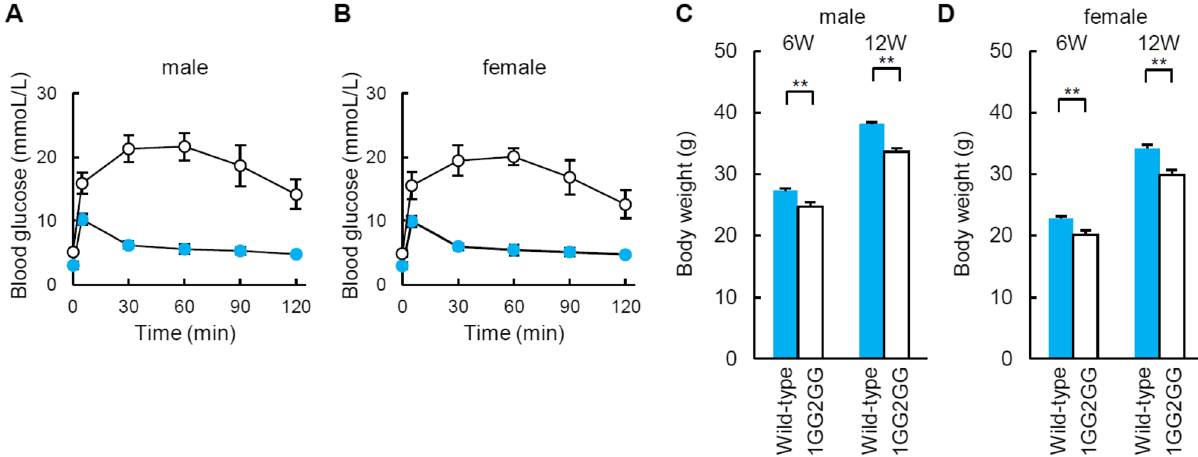
Figure 6. Glucose tolerance test and body weights of 1GG2GG mice. ( A , B ) Intraperitoneal glucose tolerance testing of wild-type (blue: n = 6) and 1GG2GG mice (white: n = 6) at 12 weeks of age [( A ): male, ( B ): female]. ( C , D ) Body weights of wild-type (n = 6) and 1GG2GG mice (n = 6) at 6 and 12 weeks of age [( C ): male, ( D ): female]. The error bars represent the standard error. ** p <